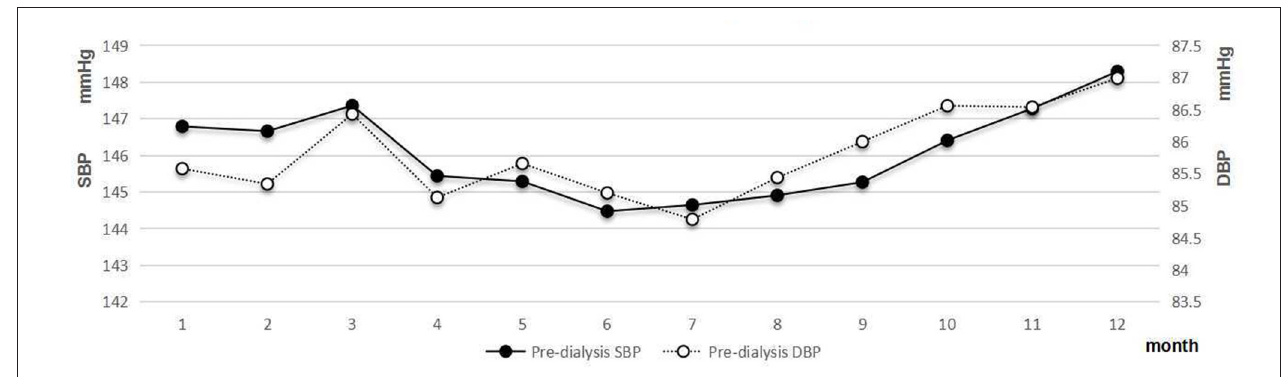
FIGURE 3 | Pre-dialysis systolic and diastolic blood pressure of patients with hemodialysis.